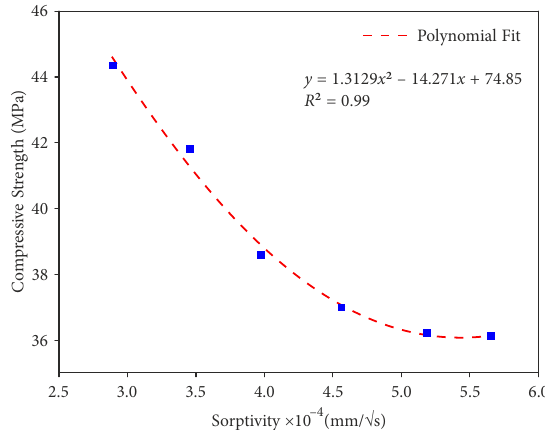
Fig. 9. Relation between compressive strength and sorptivity of the lightweight concrete